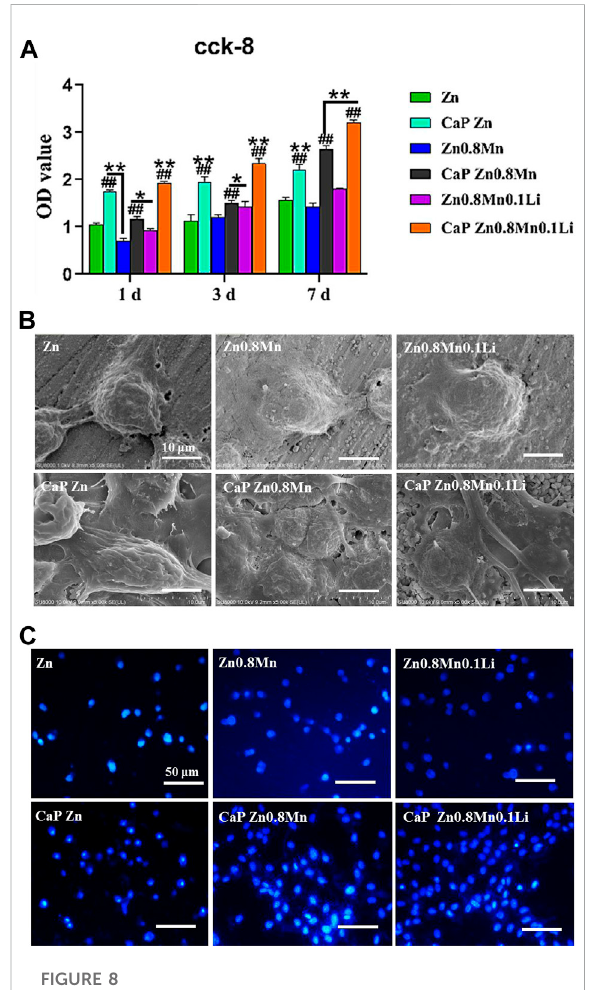
FIGURE 8 Cytocompatibility of Zn-based alloys and CaP-coated Zn- based alloys. (A) CCK-8 cells proliferation experiment of MC3T3- E1 after cultured 1, 3, and 7 days in vitro . (B) SEM and (C) DAPI nuclear staining pictures of MC3T3- E1 cells on different samples surface after cultured 3 days * p < 0.05 compared to